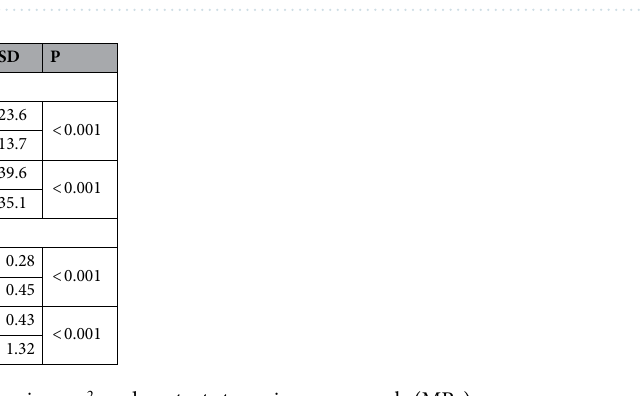
Figure 7. Sample imaging of the contact area for each of the cages.